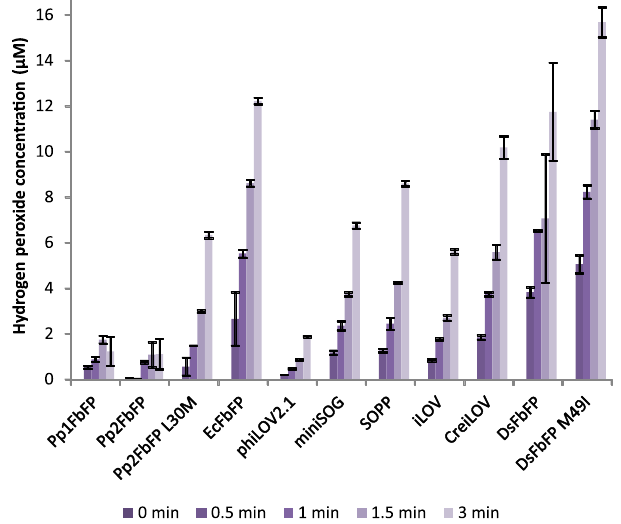
Figure 5. Quantification of LOV-PS-catalyzed hydrogen peroxide formation. The determination of hydrogen peroxide, produced by the LOV-PS as a reaction of blue-light exposure ( λ max = 447 nm, ~10 mW cm − 2 ), was performed with purified proteins (final concentration OD 450 = 0.05) by applying the Amplex ® Red Hydrogen Peroxide/Peroxidase Assay Kit. The bars show the time-dependent increase of hydrogen peroxide formation for all tested photosensitizes. The control experiment in the dark did not lead to detectable H 2 O 2 production for all tested proteins (Supplemental Fig. S2). The data represent the mean values of three independent experiments, the error bars the calculated standard